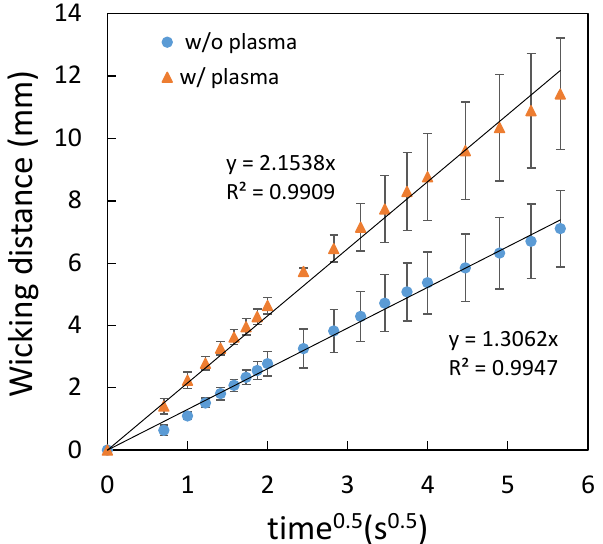
Figure 7. Comparison between the flow behavior of the printing paper with and without plasma treatment.